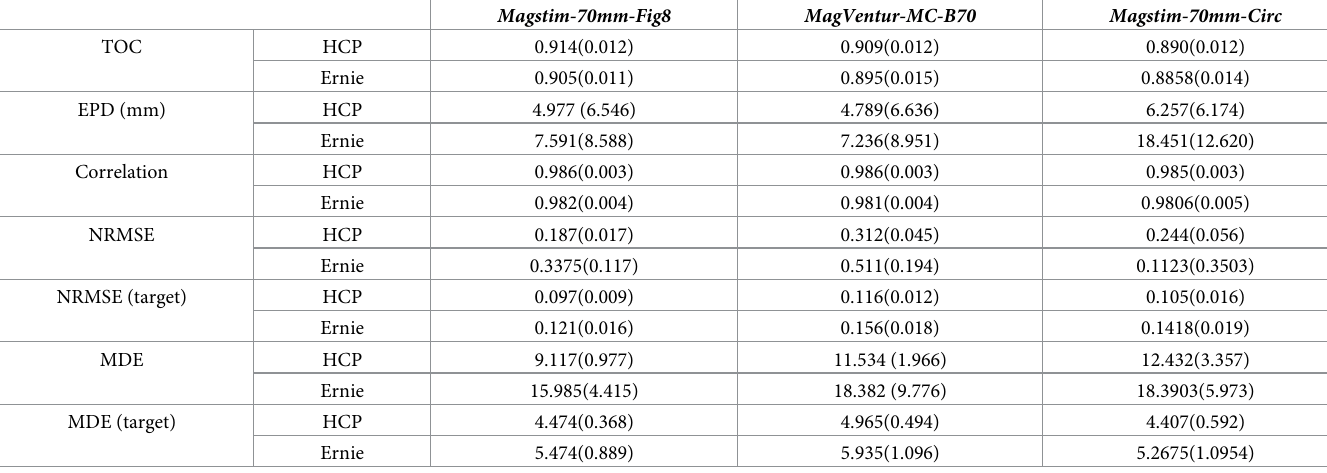
The evaluation metrics include the Target overlapping coefficient (TOC), the E-field peak distance (EPD) error, the Correlation, the Normalized root-mean-square error (NRMSE) and the Mean directional error (MDE) in the volume